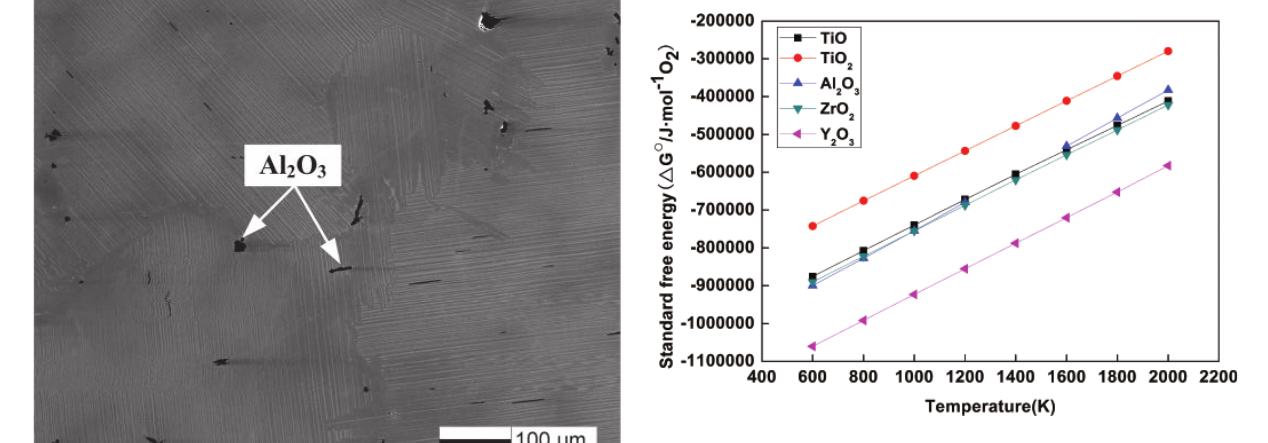
Fig. 10: The standard free energy of formation of some relevant